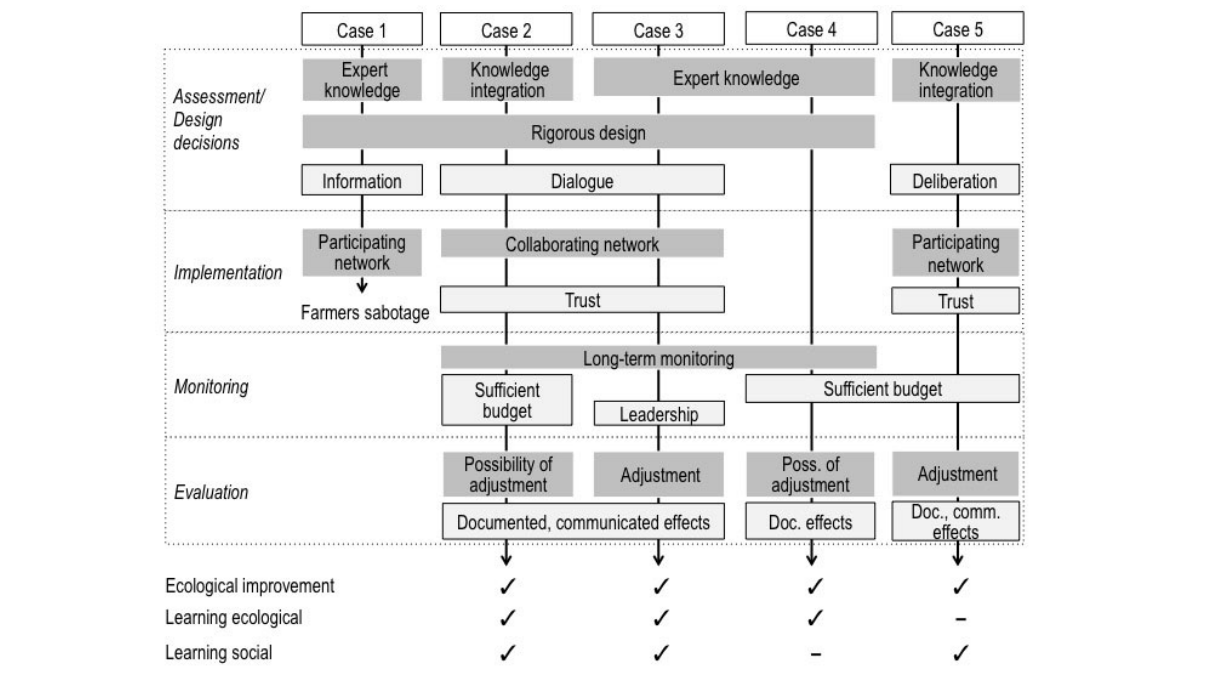
Fig. 3 . Phases of adaptive management projects with influencing factors and results found in the cases. Dark grey boxes refer to ecological uncertainty; light grey boxes to social uncertainty. The factors of bridging organizations, local scale, legal context, and reversibility are integrated into Table